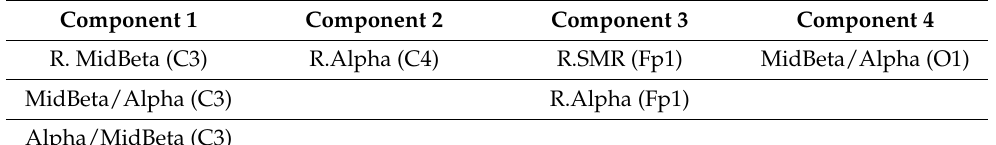
Table 4. Seven parameters representing the main components with eigenvalues of 0.8 and above.